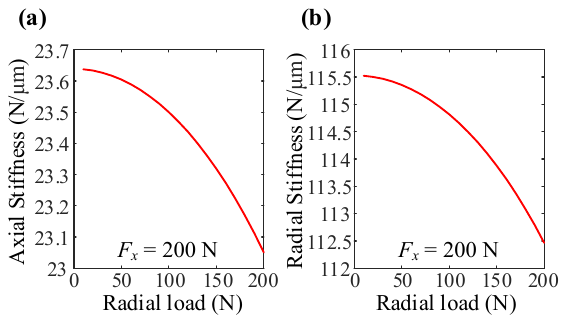
Figure 9. The stiffness variation for ball bearing acted by the combined large axial load and small radial load: ( a ) axial stiffness varies with radial load; ( b ) radial stiffness varies with radial load.